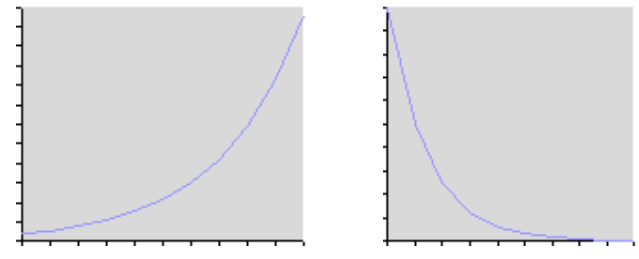
Figure 1. Two types of feedback conditions